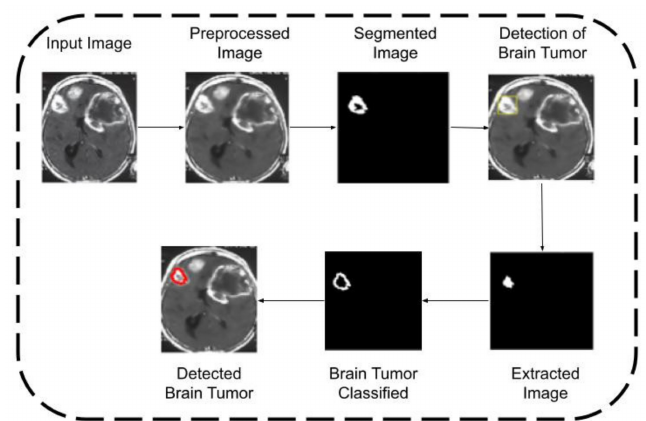
Figure 3. Operation of input image2.